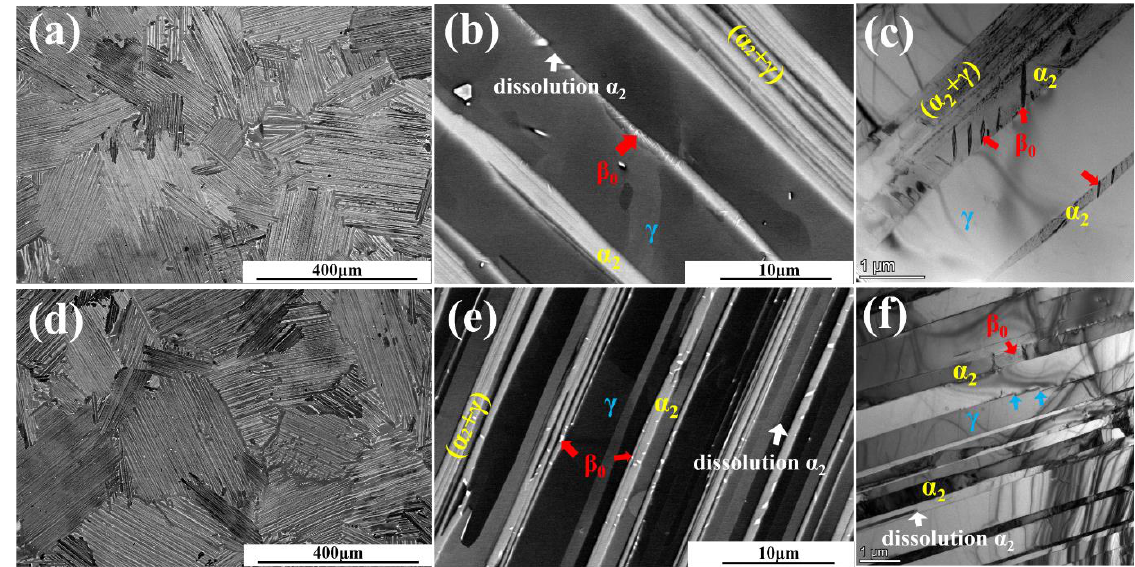
Figure 3. Microstructures of P-HIPed TNM alloys after different exposure treatments. ( a – c ) 950 °C/2 h/FC; ( d – f ) 1050 °C/2 h/FC.